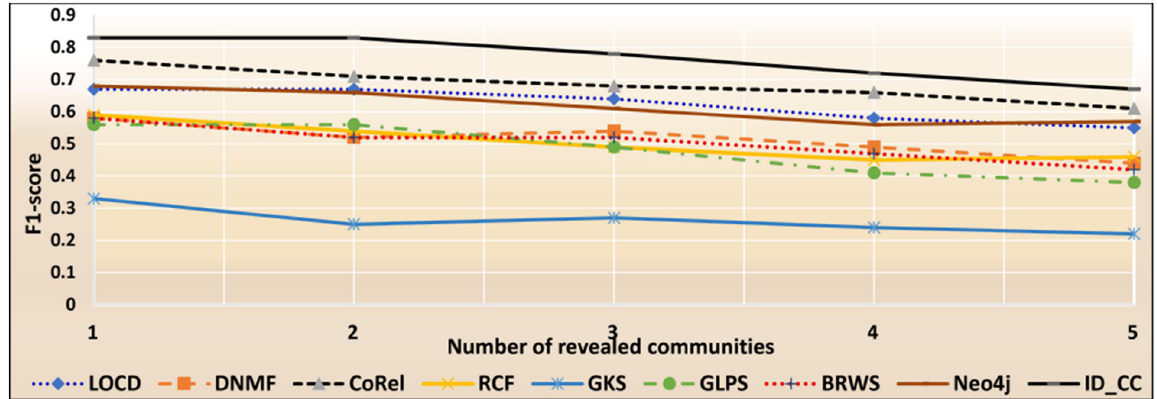
Fig 30. The accuracy of each method in terms of F1-score for detecting the Facebook Social circles cross-communities resulted from the overlapping of m number of communities ( m = 1, 2, ... , 5).